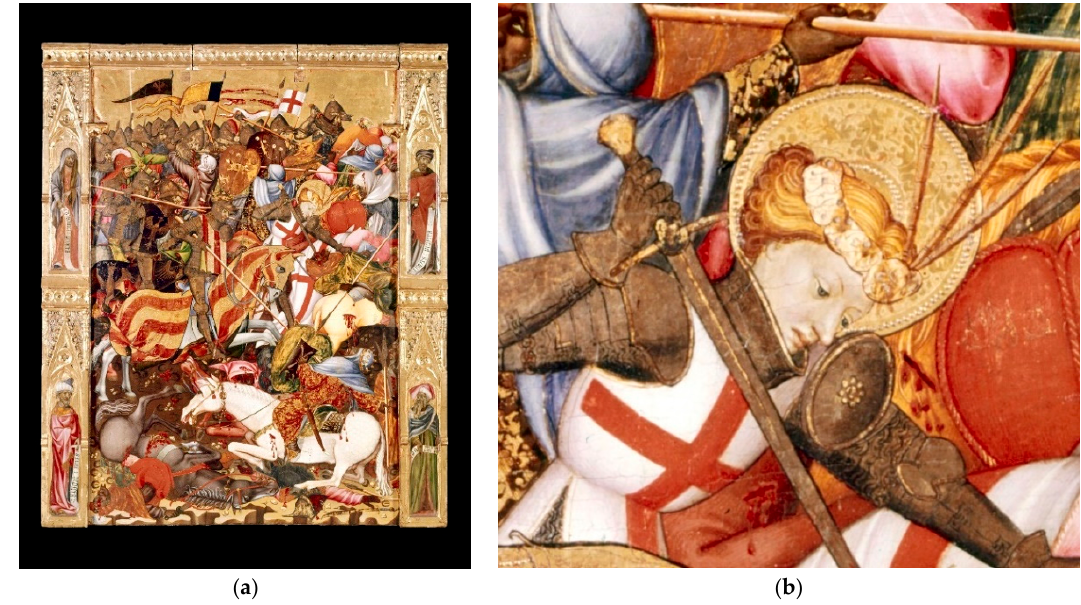
Figure 38. Miquel Alcañiç and Marçal de Sas, Altarpice “del Centenar de Ploma”, Valencia, 1400–1405, Victoria and Albert Museum © Used with permission of the Victoria and Albert Museum, London. ( a ) Central panel: Jaume I fighting together with St George to defeat the Muslim king of Valencia at the Battle of El Puig; ( b ) detail of St George decorated with the Cross of St George and wearing three elegant and slim feathers (ploma) that characterized the garments of “The Hundred of the Feather”.